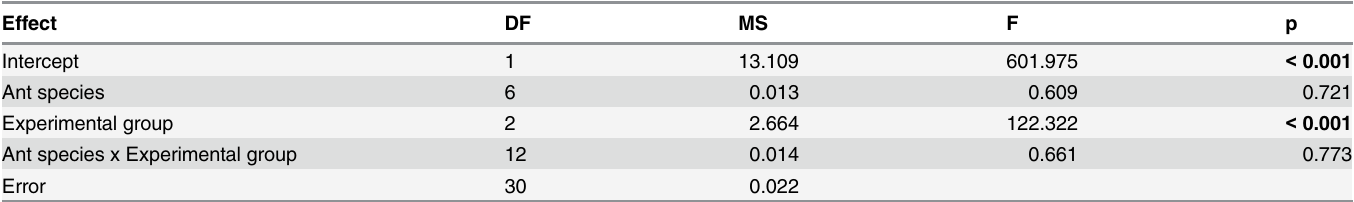
Table 2. Results of the GLM testing the effect of ant species and experimental groups on the repellency index. The experimental groups were: (1) secretion of one non-ovigerous female of Acutisoma longipes , (2) secretion of one ovigerous female of A . longipes , and (3) distilled water (control). Significant p-values are shown in bold.